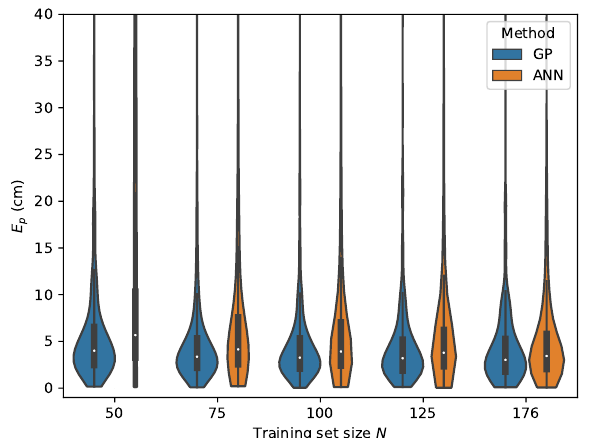
Figure 20. Cross-validation with set B where the r rel , all input features are used.